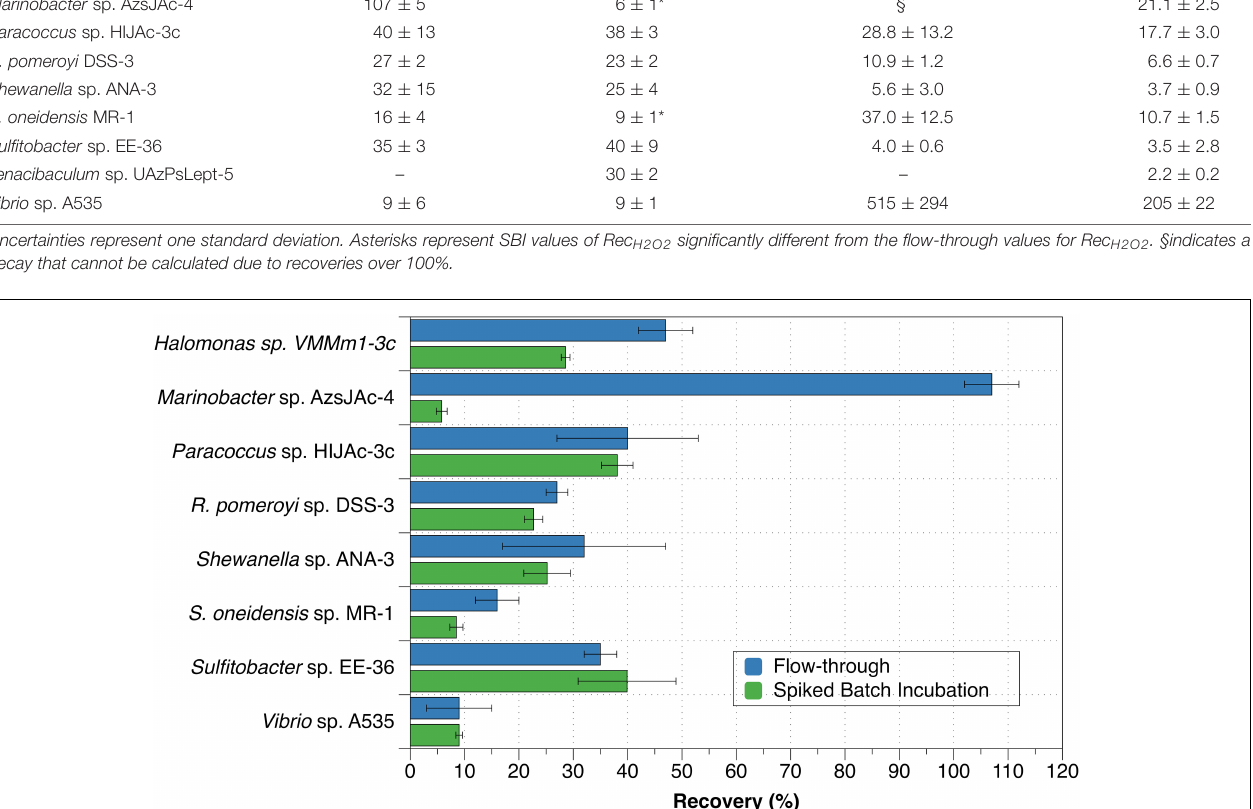
307 ± 207, 2.38 ± 1.40, 0.88 ± 0.53, and 0.78 ± 0.15